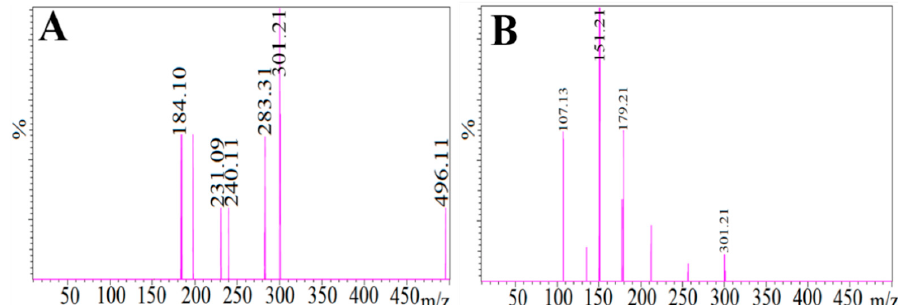
Figure 9. Mass spectrum of ( A ) catechin hydrate (CH) parent ion (protonated precursor [M–H] − ions at m/z 289.23) and ( B ) catechin hydrate (CH) product ion (major fragmented product ion at m/z 245.20) showing fragmentation transitions.